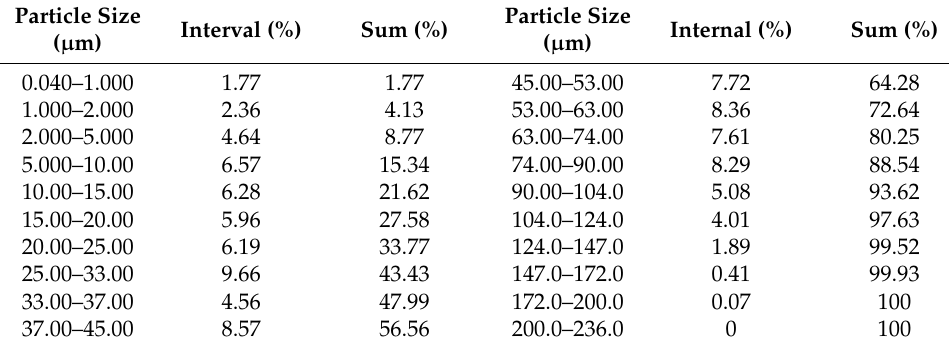
Figure 3. SiO2 powder particle size distribution. Table 3. Quartz sand size distribution.